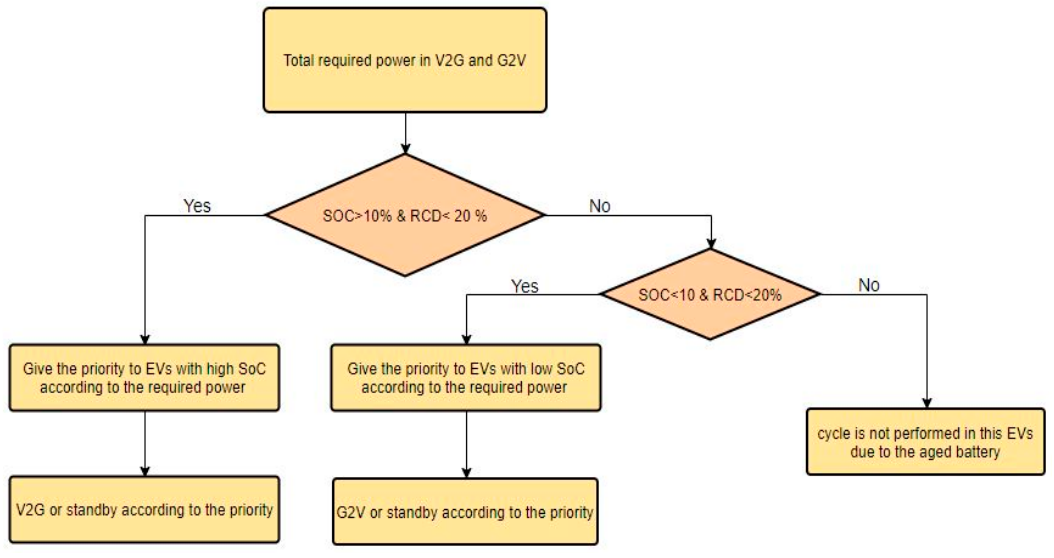
Figure 3. The low-layer of controller for each EV.